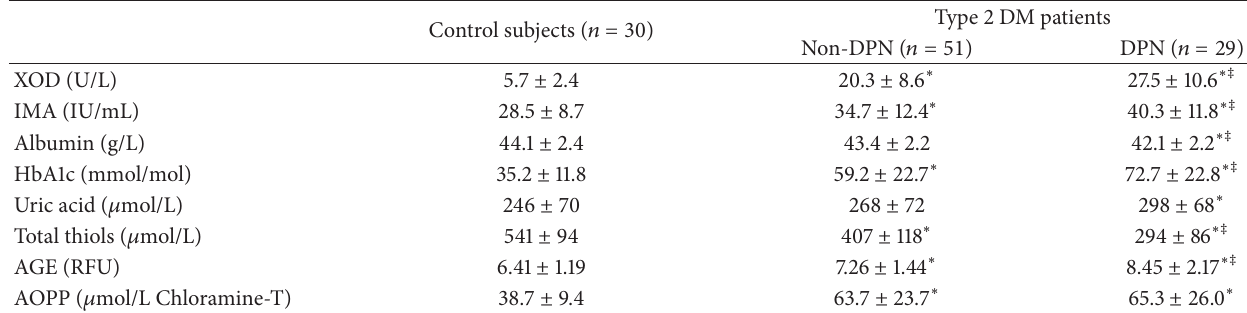
Table 2: Serum XOD activity, uric acid, IMA, and other biomarkers of protein modifications in control subjects and type 2 diabetes mellitus patients with and without diabetic peripheral neuropathy.